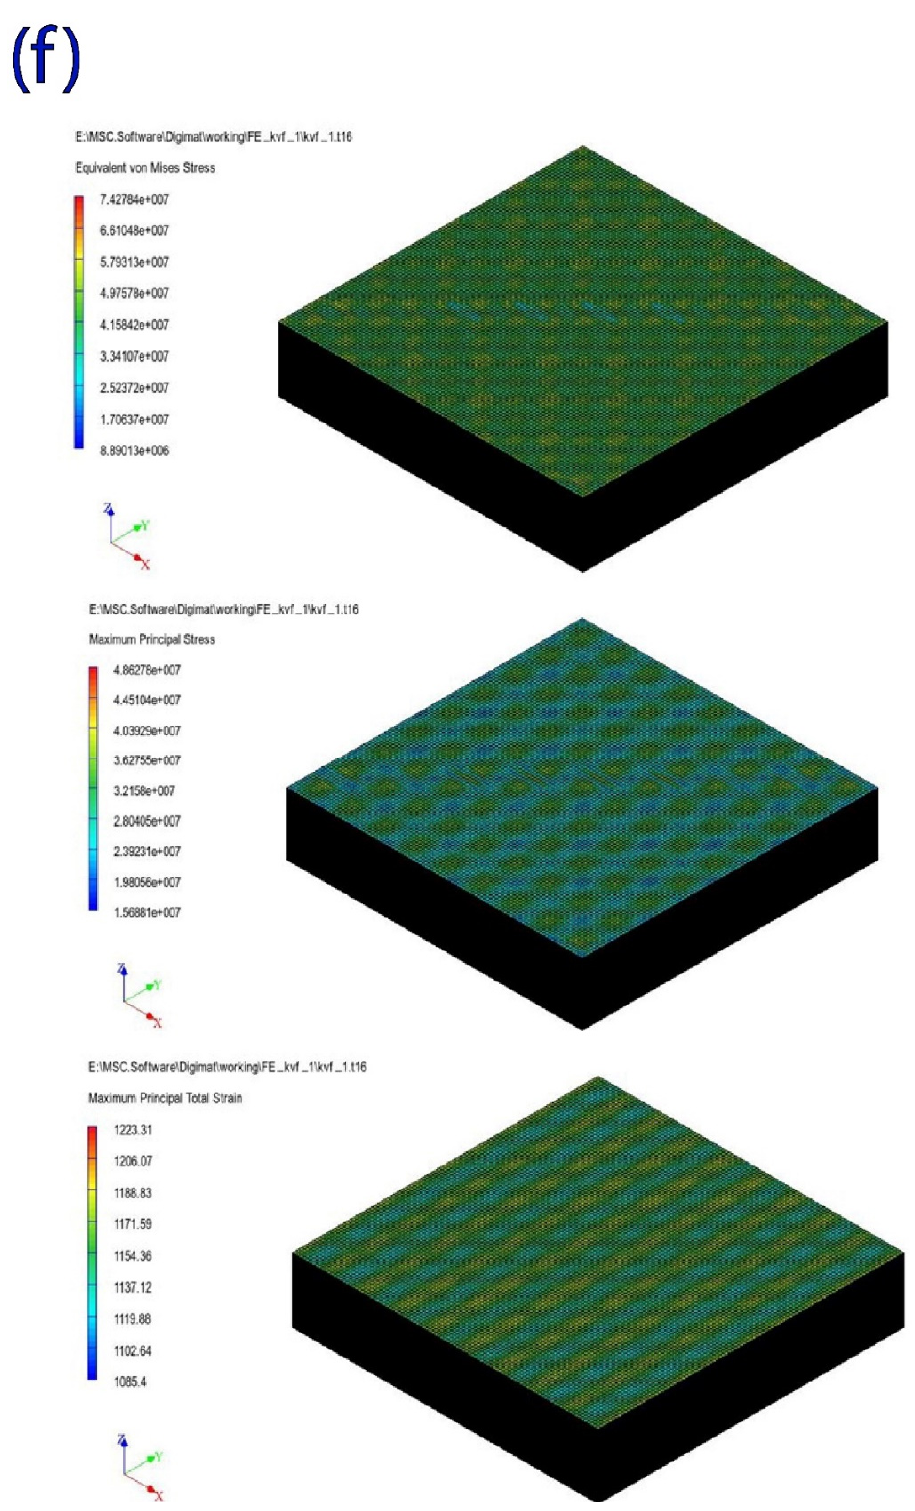
Figure 2. Digimat modeling: ( a ) RVE of filler and fibers matrix, ( b ) RVE of matrix and fibers, ( c ) RVE of filler, ( d ) meshing of RVE, ( e ) fabric weaving style, ( f ) Digimat simulation results. Table 3. Parameters for microstructure generation of fabric. The generated RVE model was subjected to meshing (voxel) with a size of 100 mm, followed by uniaxial loading with 90 ◦